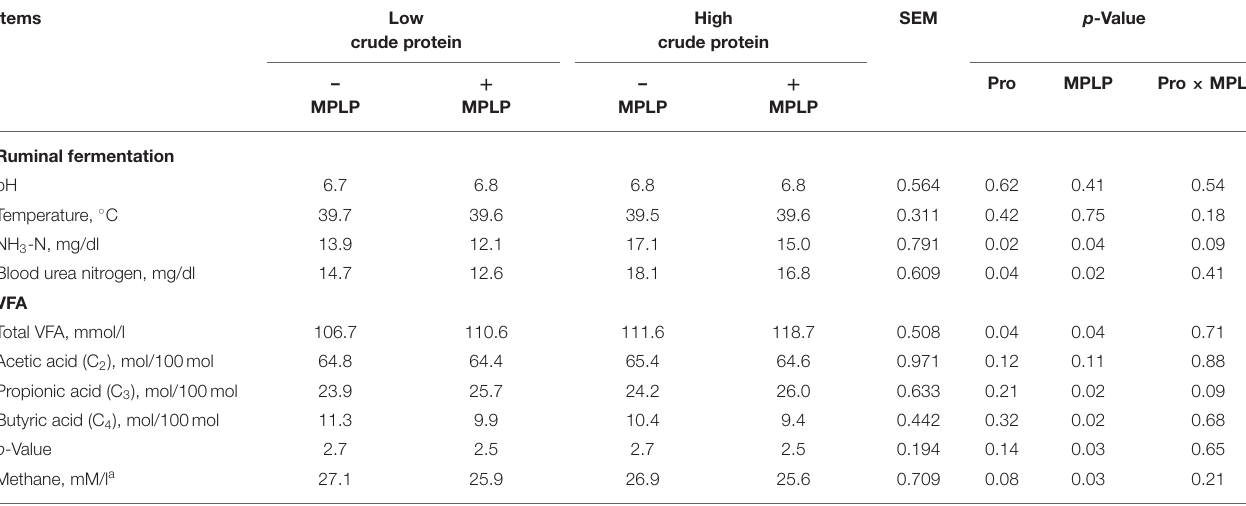
TABLE 3 | Effect of crude protein level and mangosteen peel liquid-protected soybean meal on ruminal fermentation and blood urea nitrogen in lactating dairy cows.